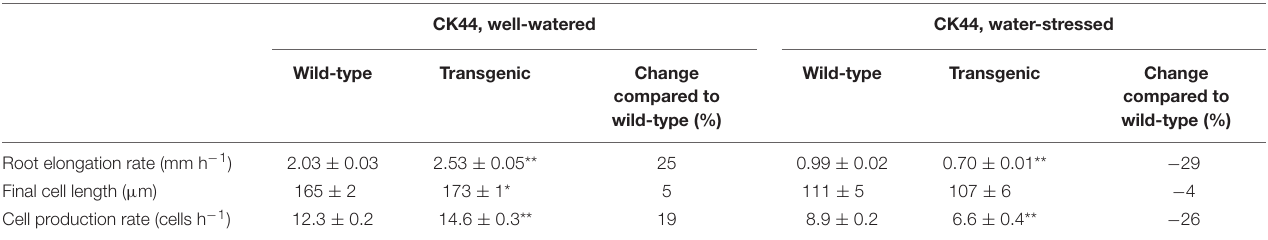
TABLE 2 | Elongation rate, final cell length, and cell production rate of the primary root in the CK44 oxalate oxidase transgenic and wild-type lines at 48 or 72 h after transplanting to well-watered or water-stressed ( − 1.6 MPa) conditions,